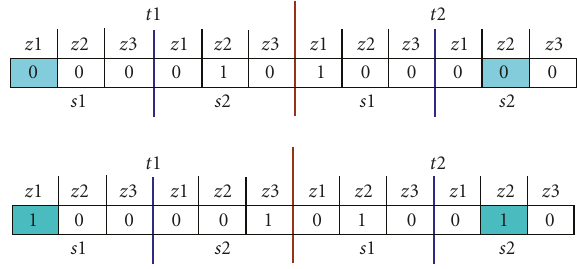
Figure 5: Mutation operation; s 1 at t 1 and s 2 at t 2 are muted to be used on z 1 and z 2, respectively.